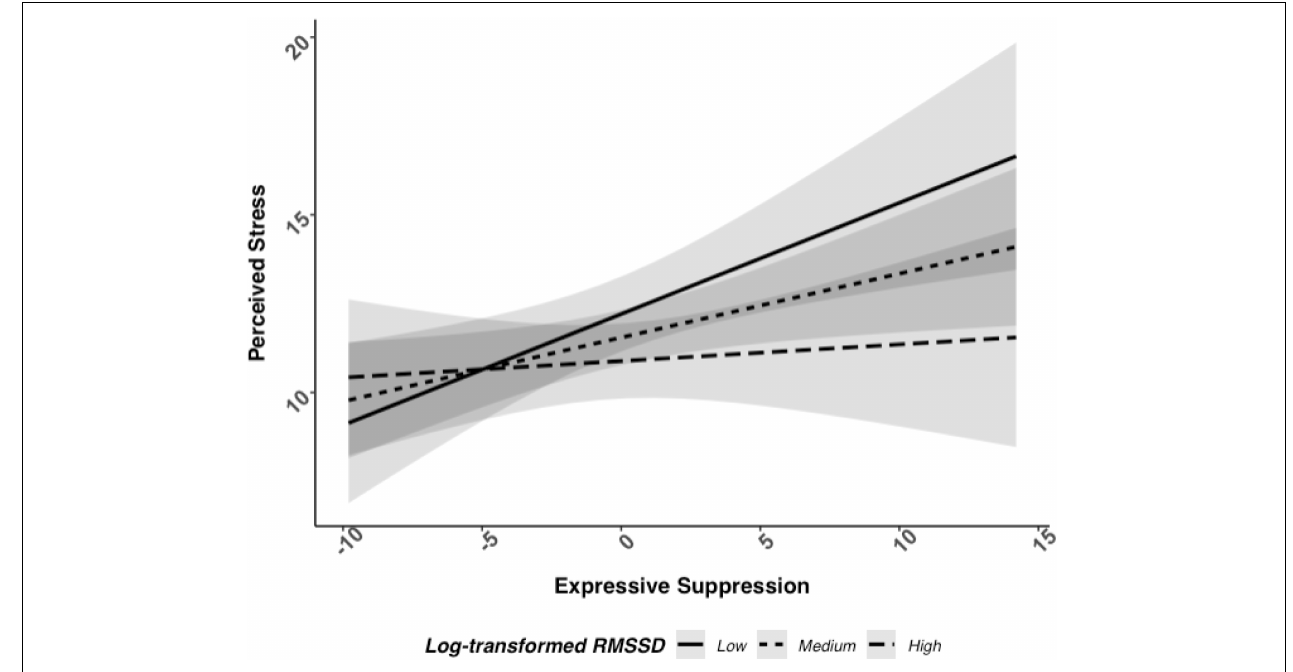
FIGURE 2 | Relationship between log RMSSD, expressive suppression, and perceived stress when adjusted with covariates.